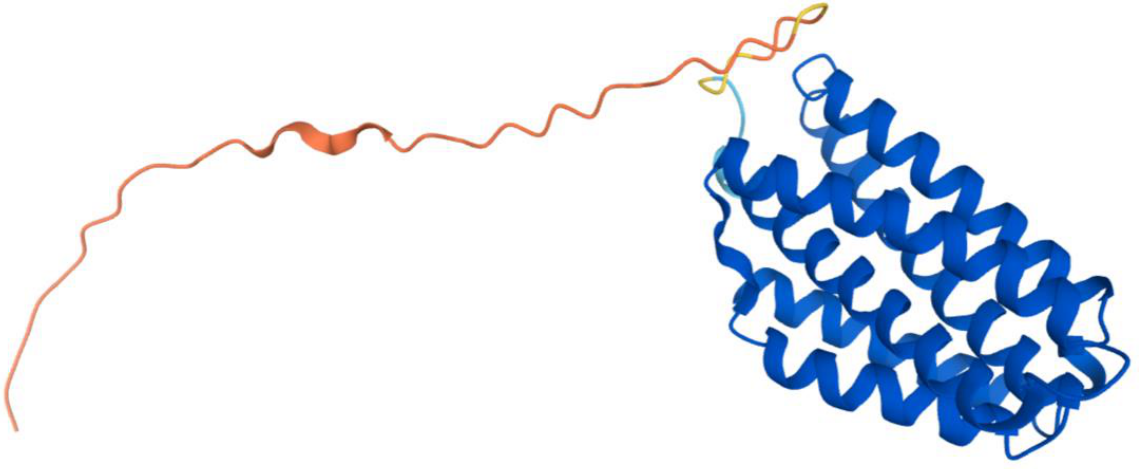
Figure 25. AlphaFold model of single chain of COQ7. Model color corresponds to model confidence as described in Figure 4. Figure was generated by the AlphaFold Protein Structure Database [39,54].